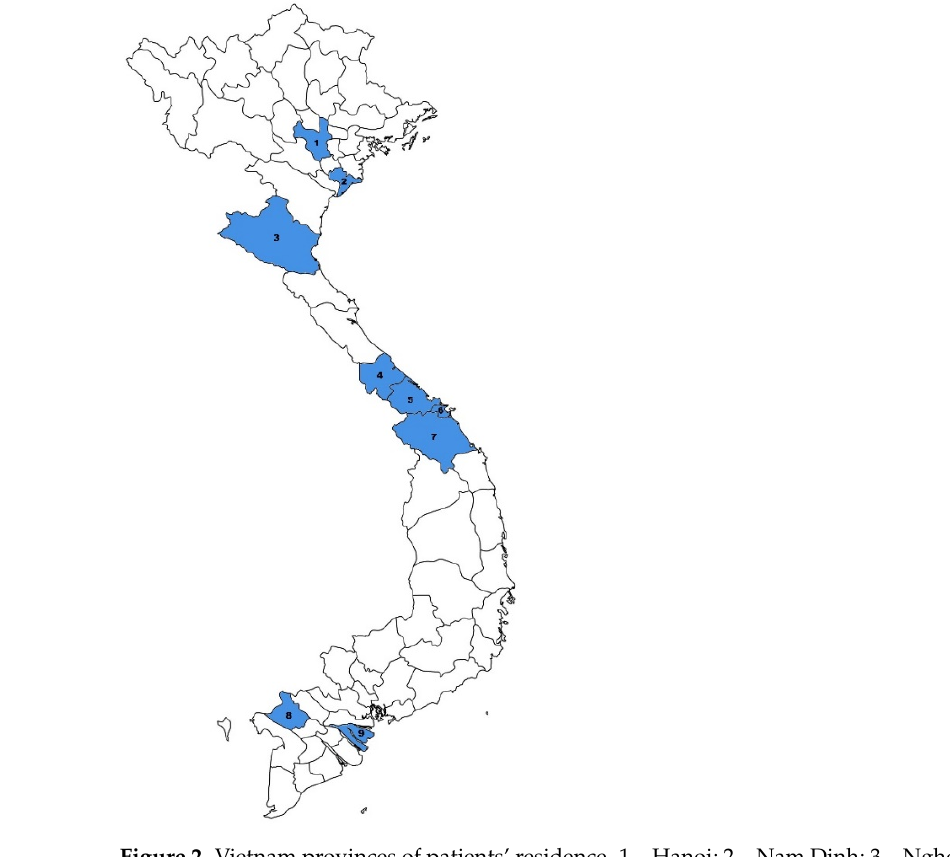
Figure 2. Vietnam provinces of patients’ residence. 1—Hanoi; 2—Nam Dinh; 3—Nghe An; 4—Quang Tri; 5—Thua Thien-Hue; 6—Da Nang; 7—Quang Nam; 8—An Giang; 9—Ben Tre.